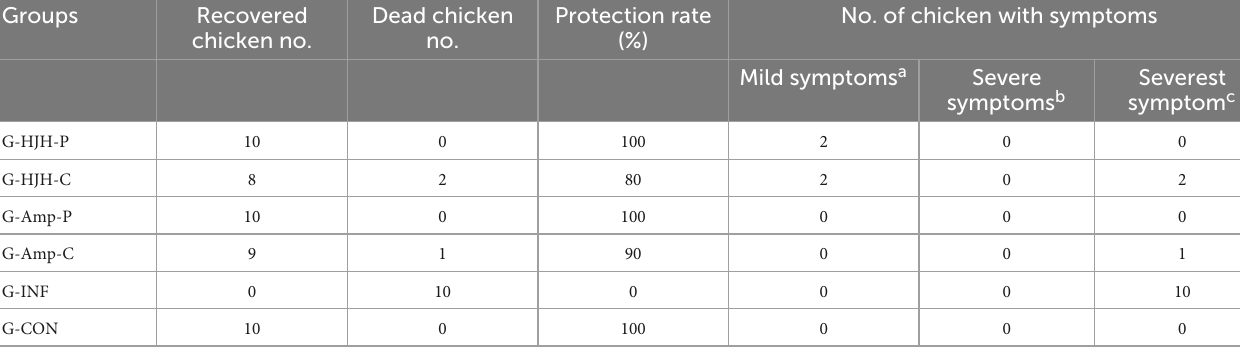
TABLE 4 Groups of chickens infection test.